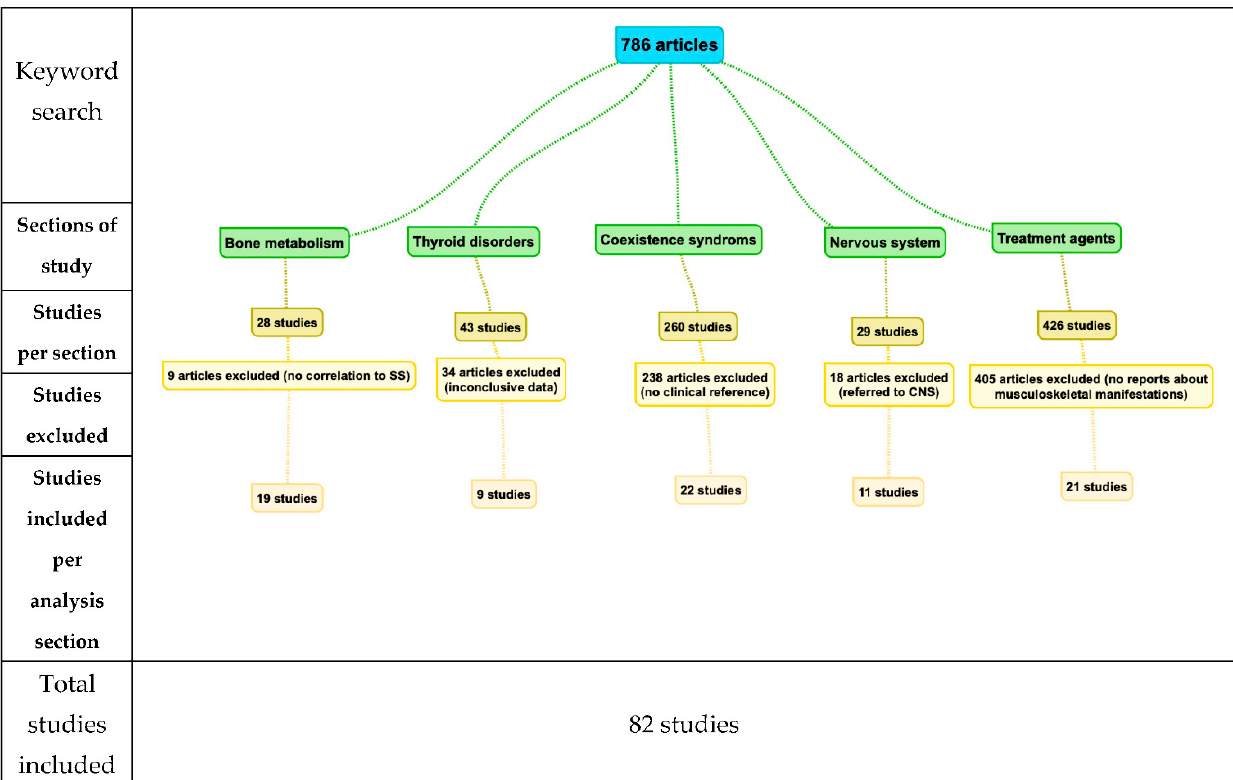
Figure 1. Flowchart of Study analysis.